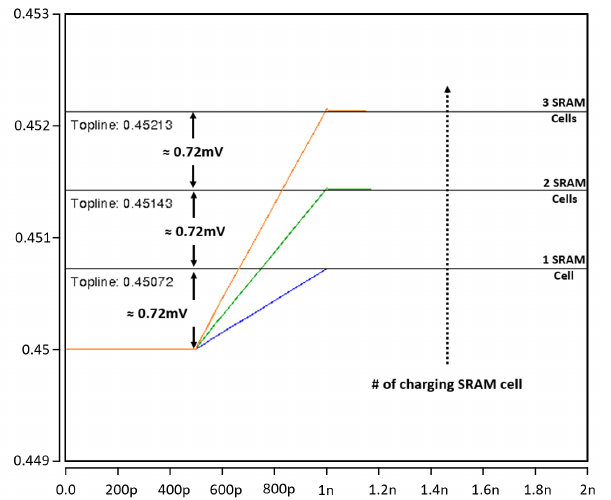
Figure 9. Comparison of read bitline (RBL) charging range with a different number of SRAM bitcells (1 cell–3